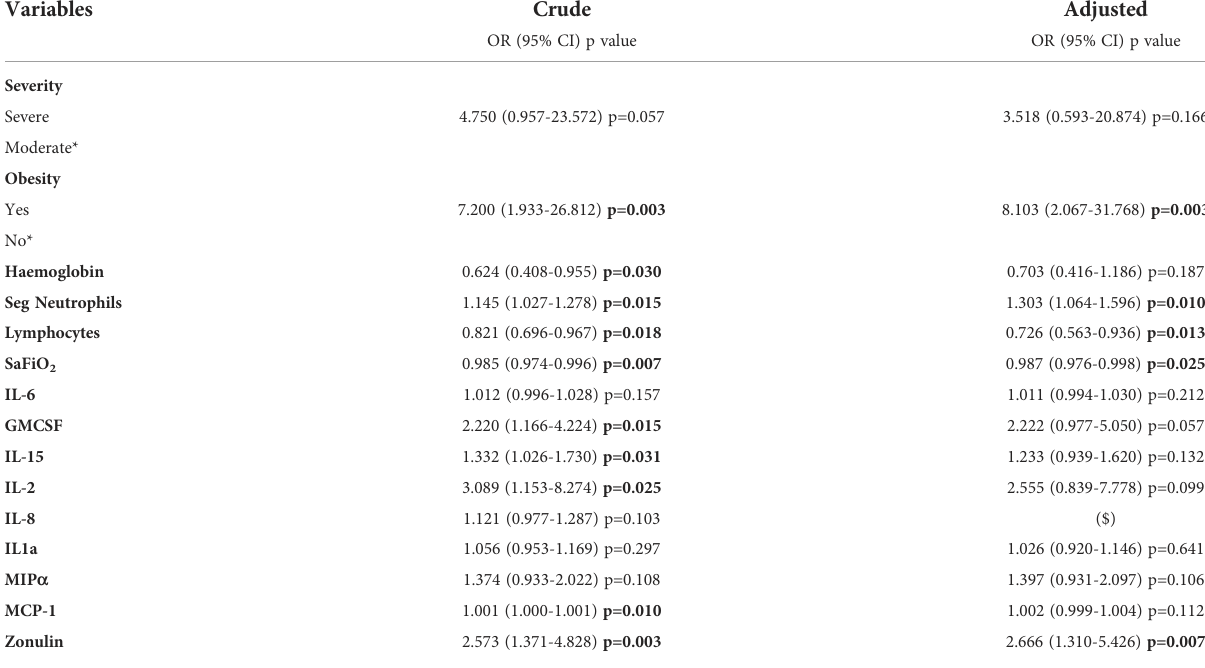
TABLE 4 Crude and adjusted* logistic regression analysis for predictability of death according to different factors at baseline.